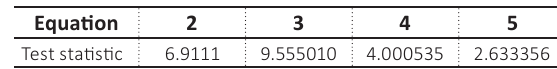
Table 3. ARDL bound test for cointegration relationship